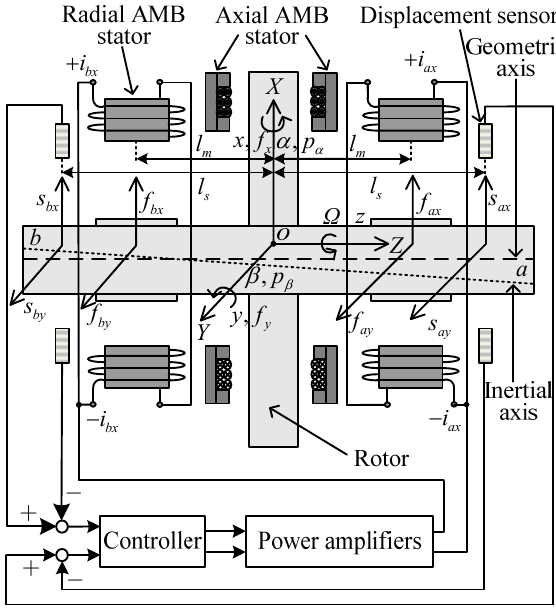
Figure 1. Diagram of the AMB-rotor system in the x - z